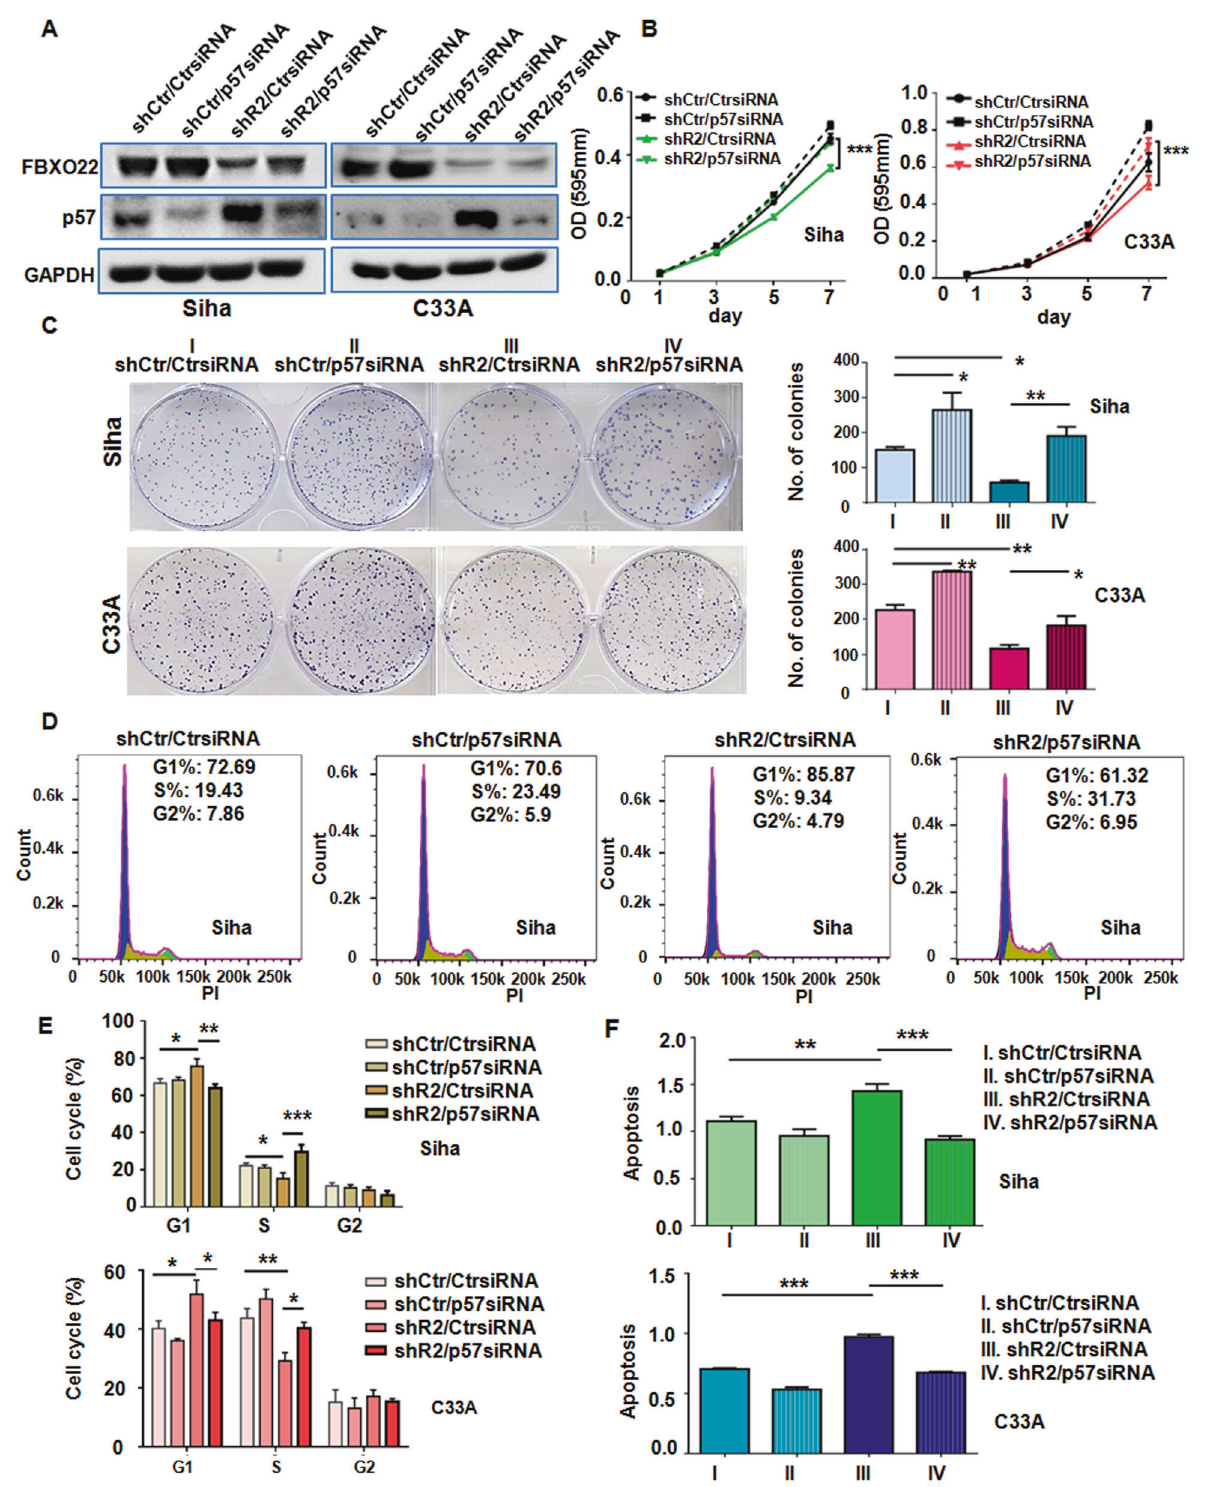
Fig. 7 FBXO22 promotes HCC cell growth and survival by silencing p57Kip2 expression. A The protein levels of FBXO22 and p57Kip2 were detected by Western blotting in SiHa and C33A control (shCtr) and FBXO22 knockdown (shR2) cells transfected with a control siRNA (CtrsiRNA) or a p57Kip2 siRNA (p57siRNA). B , C MTT ( B ) and colony formation ( C ) assays were used to measure the viability and proliferation in SiHa and C33A cells with or without FBXO22 and/or p57 knockdown. D , E Cell cycle was analyzed in SiHa and C33A cells with or without FBXO22 and/or p57 knockdown. F Cell apoptosis was analyzed in SiHa and C33A cells with or without FBXO22 and/or p57 knockdown. Data are shown as mean ± SEM from triplicate measurements. * P < 0.05, ** P < 0.01, *** P <